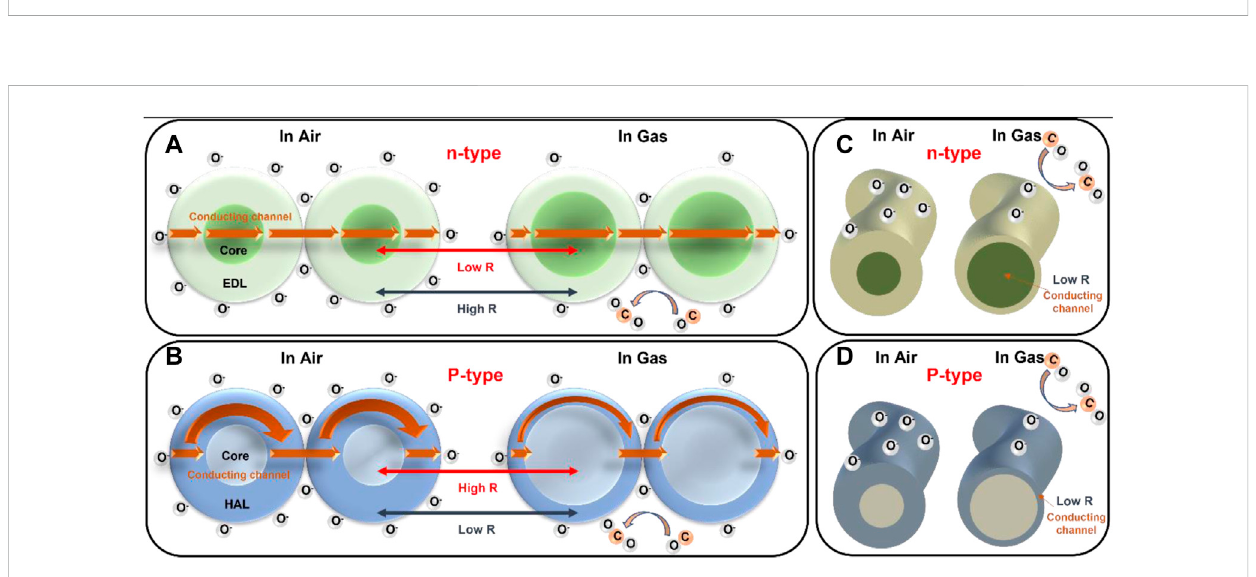
FIGURE 5 Schematicdiagram of gas sensing mechanism and conduction model for (A) n-type MOS particle model, (B) p-type MOS particle model, (C) n-type MOS nanowire model, (D) p-type MOS nanowire model.